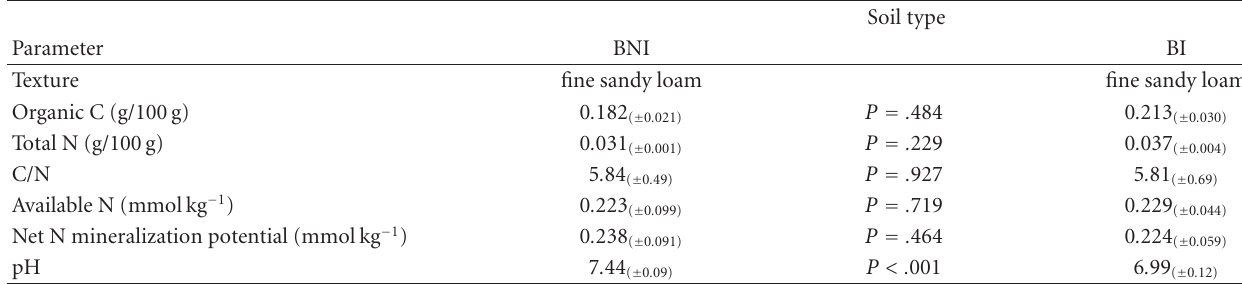
Table 1: Initial properties of the